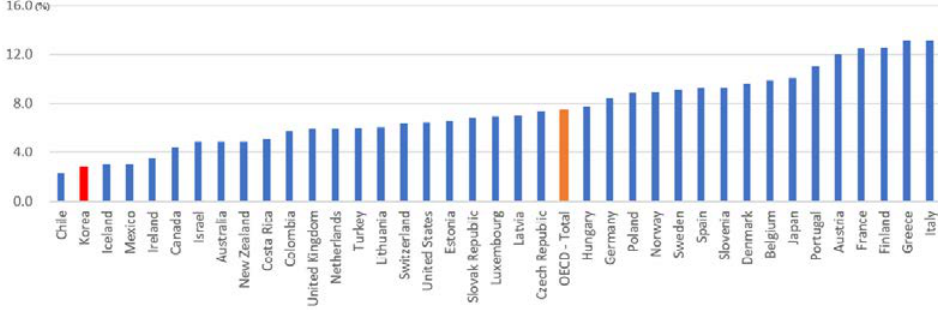
Figure 14. Public social expenditure as a share of GDP (2019). Source: OECD [51].